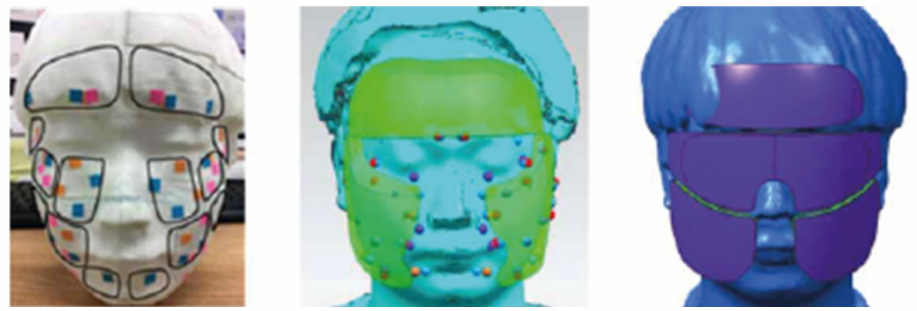
Figure 7. LED positioning-based LED mask basic design.